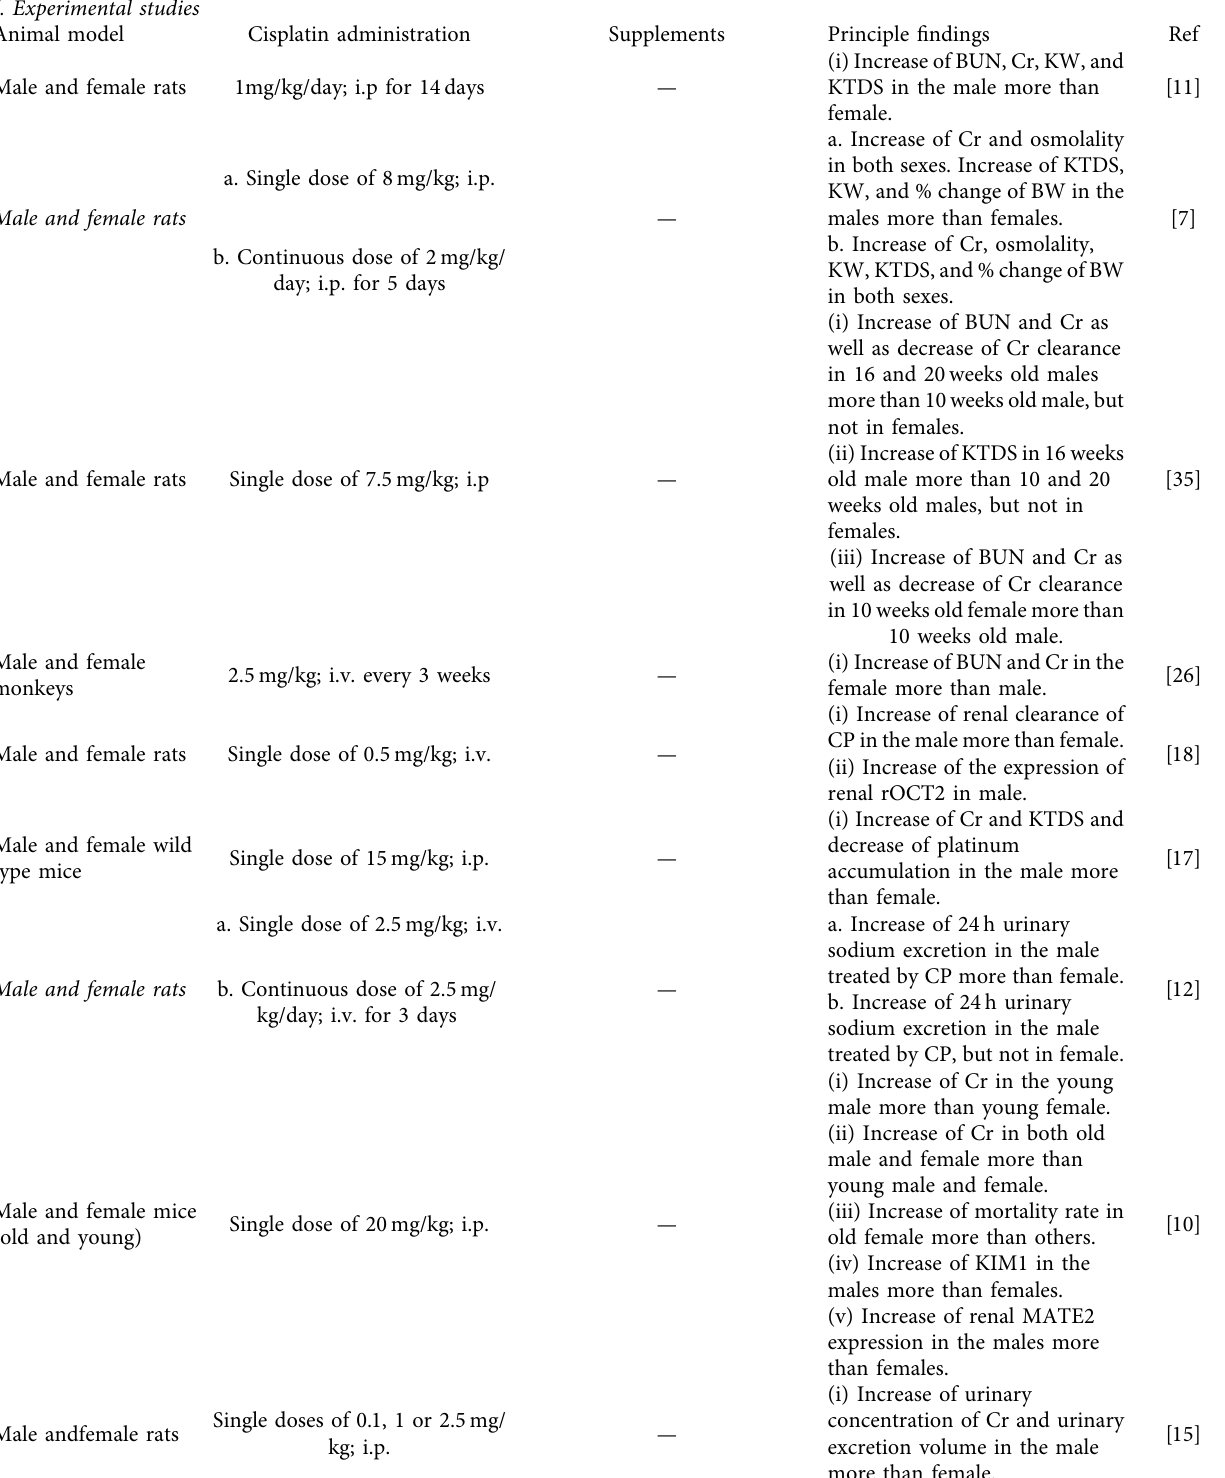
Table 1: The experimental and clinical studies performed in association with CP-induced